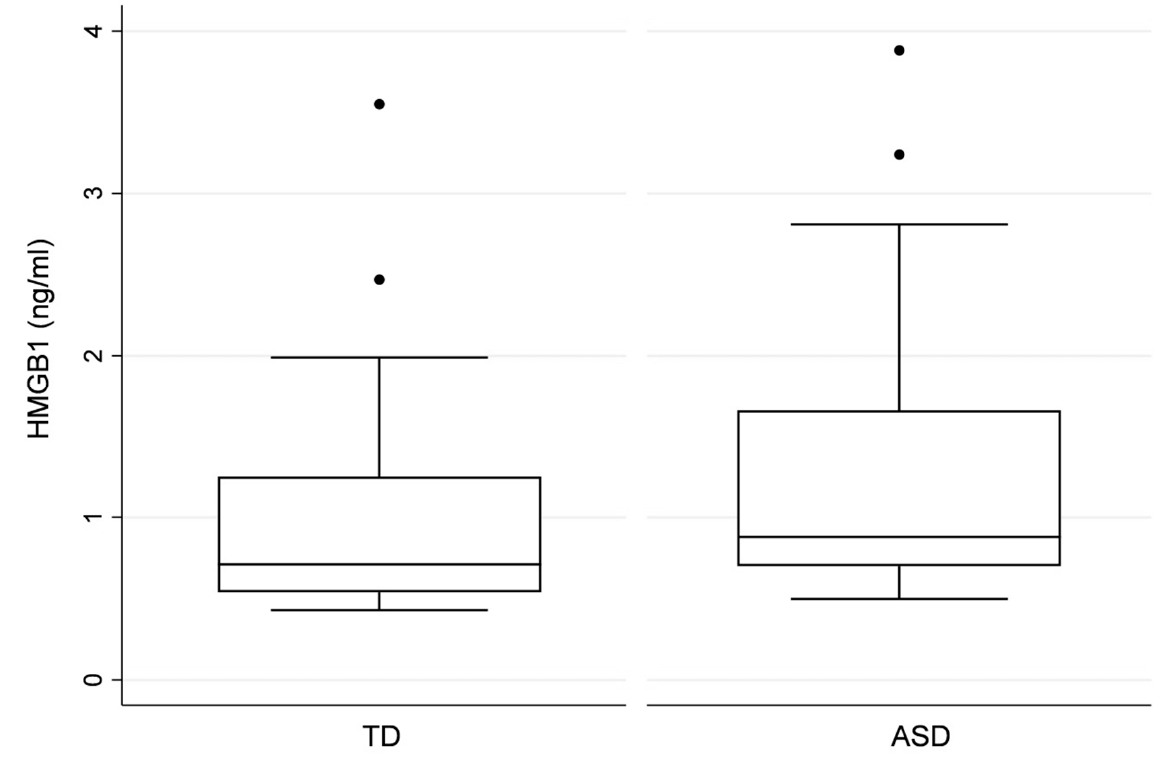
Figure 1. Distribution of HMBG1 serum concentrations in ASD and TD children. Table 3. Correlations a between HMGB1 serum concentrations and AQ b , EQ c , SQ d , and IQ scores in the total population and the ASD